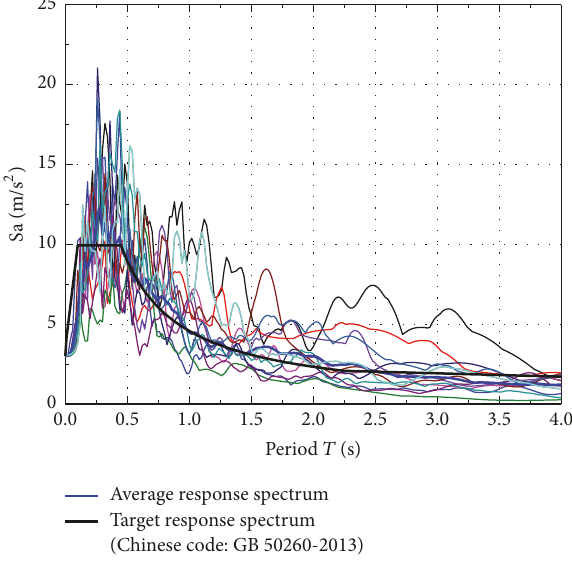
Figure 20: Seismic response